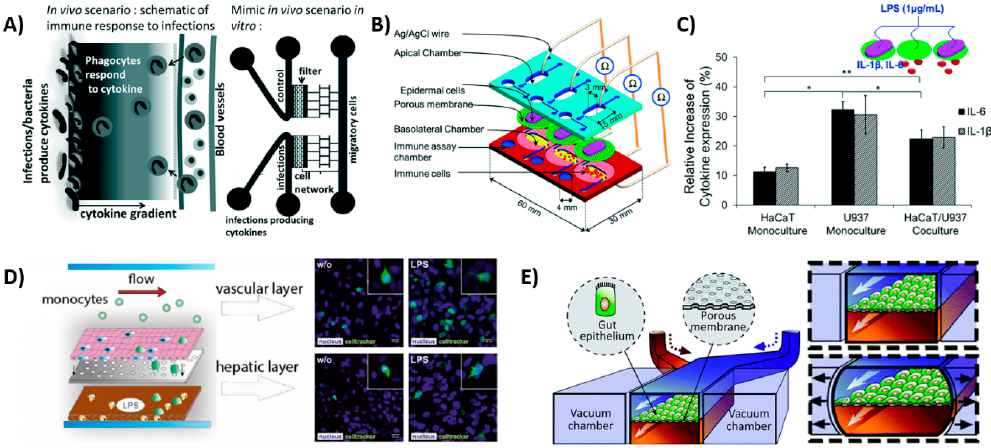
Figure 4. Schematic views of OoCs with immune cell components. ( A ) Inflammation-on-a-chip by Gopalakrishnan et al. [75] mimicking the cytokine gradient in a normal wound and the migration of immune cells. Reproduced from Ref. [75] with permission from The Royal Society of Chemistry. ( B ) skin-on-a-chip by Ramadan et al . [80] with dermal and epidermal layer, showing the interactions of DCs with the keratinocytes and ( C ) showing the expression of inflammatory cytokines IL-6 and IL-1 β in the device with a keratinocyte (HaCaT) monoculture and a dendritic cell (U937) monoculture and the co-culture. Reproduced from Ref. [80] with permission from The Royal Society of Chemistry; ( D ) liver-on-a-chip by Gröger et al. [89]; the top layer consisting of endothelial cells and macrophages and the bottom layer consisting of hepatocytes and hepatic stellate cells. LPS is used to induce an inflammatory response and monocytes start migrating; ( E ) gut-on-a-chip by Kim et al. [90], showing the peristaltic motion as a result of the two vacuum chambers. This chip model is used to incorporate immune cells in later stages of the research [82]. Reproduced from Ref. [82] with permission from The Royal Society of